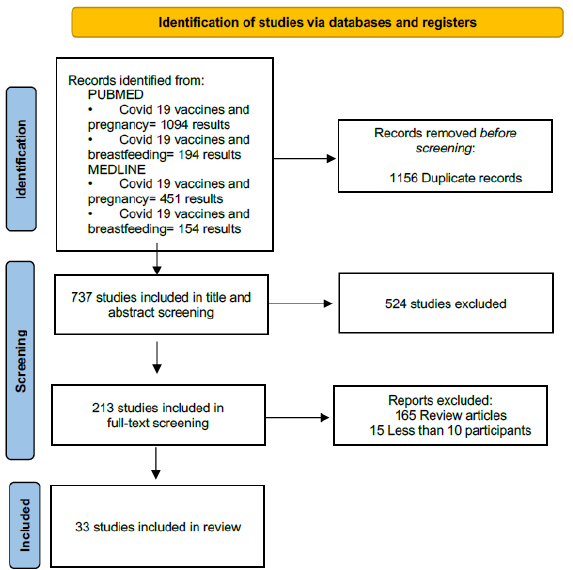
Figure 1. PRISMA: preferred reporting items for systematic reviews and meta-analyses.